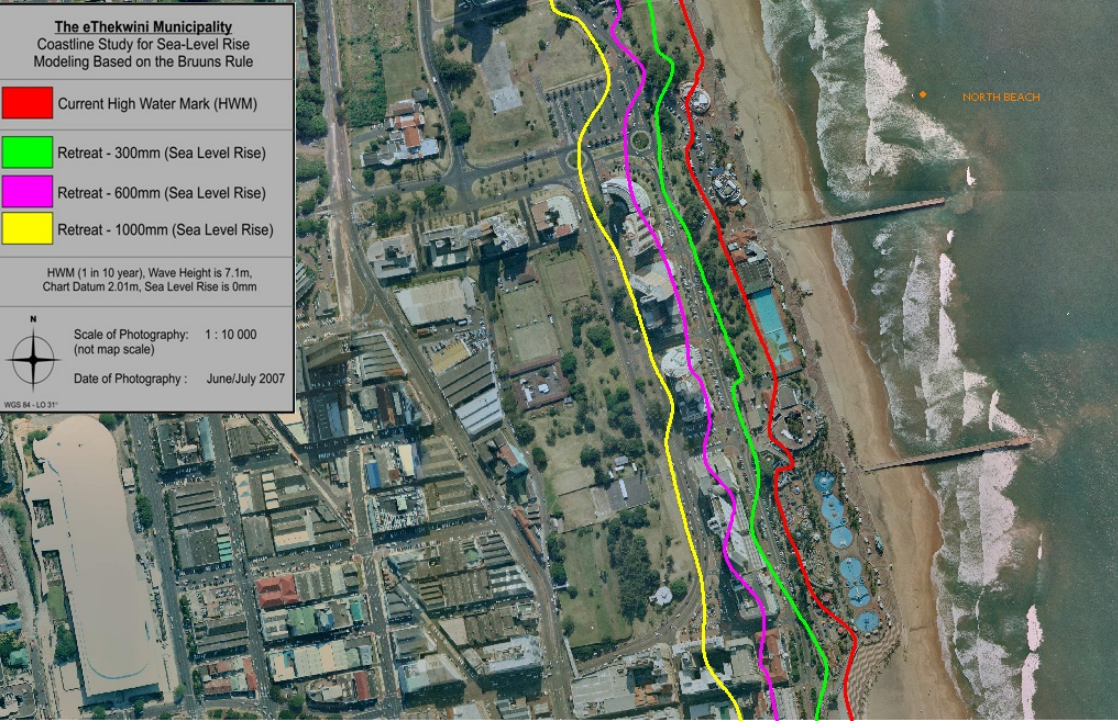
Figure 6. Present and future High Water Mark (HWM) along the Durban central beachfront